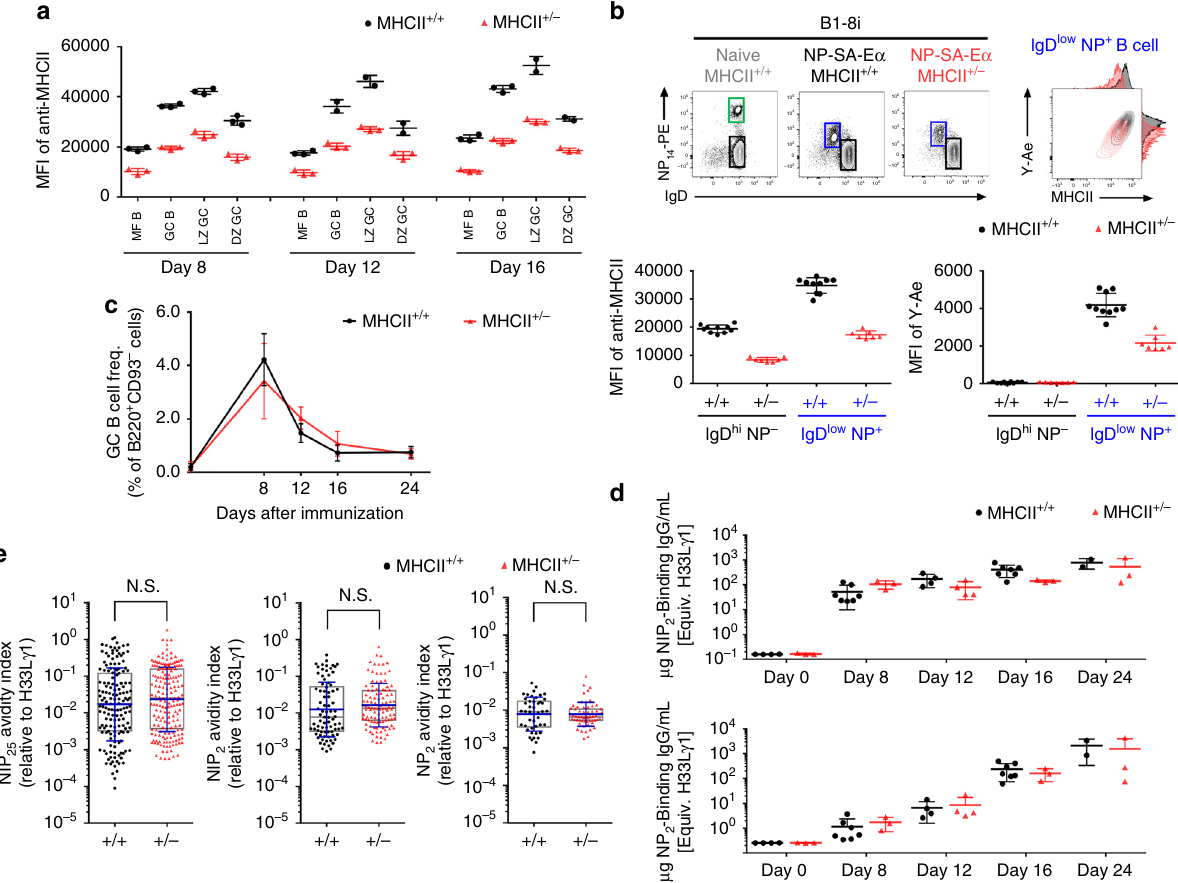
Fig. 1 MHCII haploinsuf fi ciency supports normal GC kinetics and af fi nity maturation. MHCII + / + (black circles) and MHCII + / − (red triangles) mice were immunized i.p. with 20 µ g of NP-OVA in alum ( a , c , d , e ). a MHCII expression on MF B, GC B, LZ GC B, and DZ GC B cells harvested as indicated post immunization. b B1-8.MHCII + / + and B1-8.MHCII + / − mice were immunized in the footpad with 20 µ g NP-SA-E α in alum. Cells from popliteal LNs were analyzed at 16 h. Representative fl ow plots of IgD expression and NP binding on B220 + cells from naïve and immunized B1-8.MHCII + / + mice and immunized B1-8.MHCII + / − mice are shown. Contour plots and histograms representing MHCII expression and Y-Ae-binding (E α peptide:MHCII complex) on IgD low NP + B220 + cells from B1-8.MHCII + / + (black) and B1-8.MHCII + / − (red) mice. Lower panels show MHCII expression as MFI (left) and Y-Ae- binding (right) in B-cell compartments. c Kinetics of GC responses in immunized MHCII + / + and MHCII + / − mice ( n = 2 – 5 for both strains at each time point; mean ±S.D.). d Kinetics of serum IgG responses (top, NIP 2 -binding IgG; bottom, NP 2 -binding IgG) in MHCII + / + and MHCII + / − mice. IgG concentrations were determined in a Luminex assay in reference to mAb H33L γ 1. Each point represents a single mouse with means (±S.D.) indicated. e Single-cell, Nojima cultures for day 8 GC B cells; NIP 25 -, NIP 2 - and NP 2 -speci fi c AvIn values (relative to mAb H33L γ 1) are shown 22 . Each point